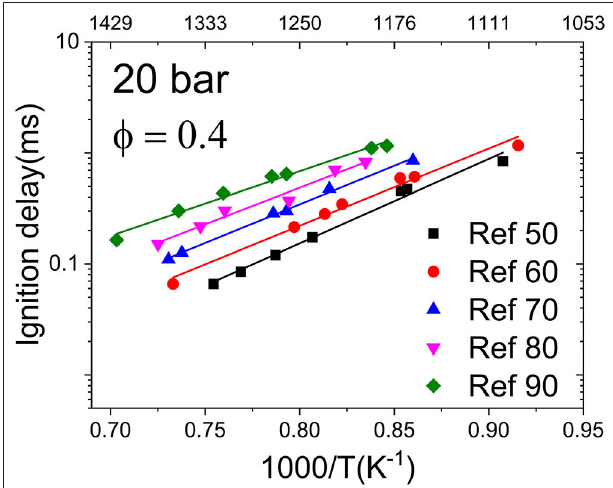
FIGURE 4 | (A) Ignition delay times (IDTs) of liquefied natural gas (LNG)/liquefied biogas (LBG) mixtures (methane number, 70–80) measured in the high-pressure shock tube (HPST) at 10 bar, φ = 0.4. (B) Comparison of the IDTs of LNGs/LBGs and the reference mixtures at 1,320K ( ± 20K), 10 bar, φ = 0.4.